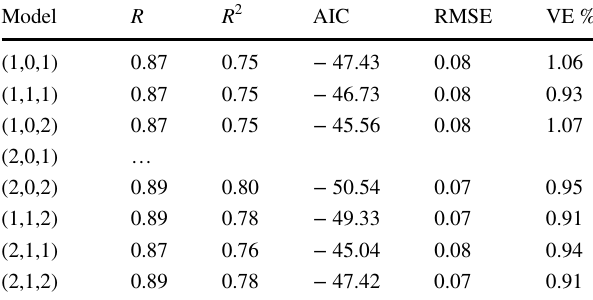
Table 8 The consequences of Na + group, order (1, 2) Model